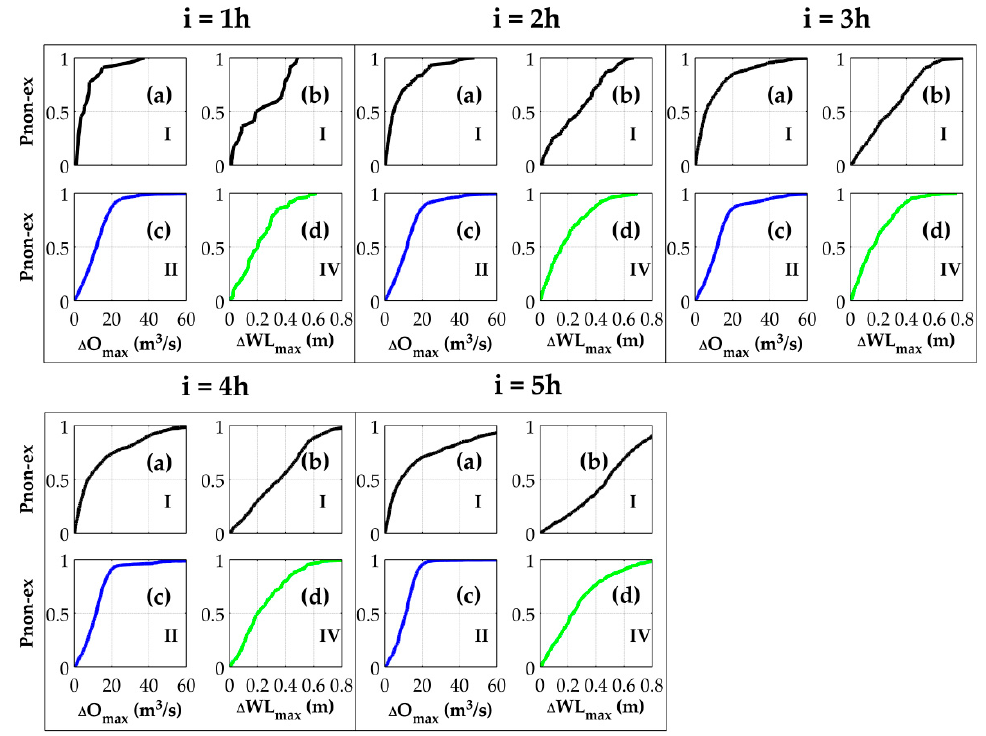
Figure 10. Probability of non-exceedance of the di ff erences in maximum discharged flows ( ∆ O max ) and the maximum levels reached by the reservoir ( ∆ WL max ), between the VEM and the BNet i ( i = 1, ... , 5 h), in quadrants I, II, and IV.